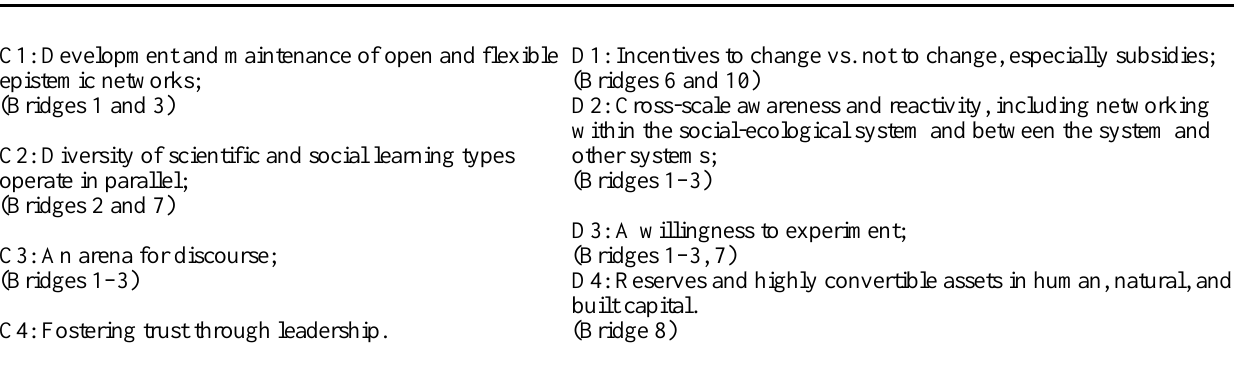
Table 2. Factors supporting transformability in social-ecological systems. Sources – 1: Gunderson et al. 2006, 2: Walker et al. 2006. Components necessary for adaptability and transformation